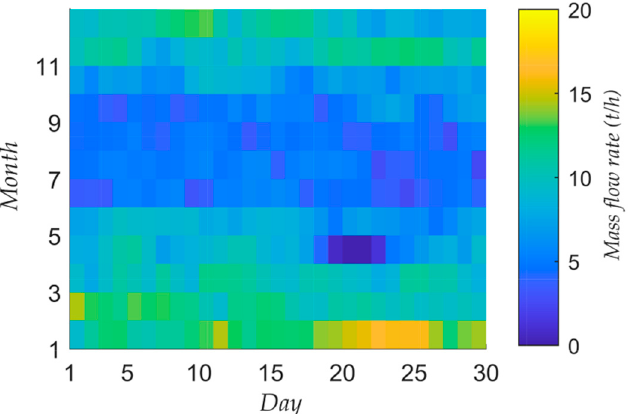
Figure 4. Daily averaged total steam mass flow rate at the investigated production site for the year 2019.